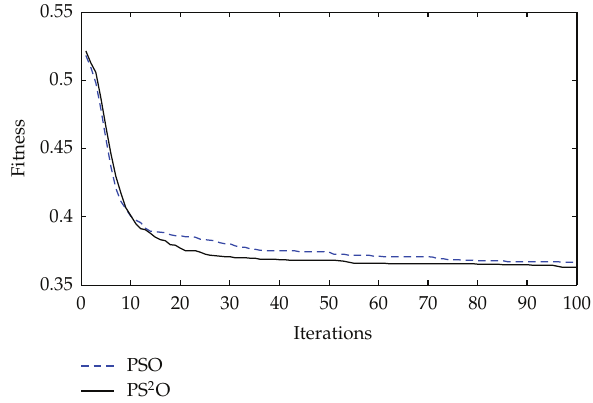
Figure 13: The top-level search process based on PS 2 O and PSO.